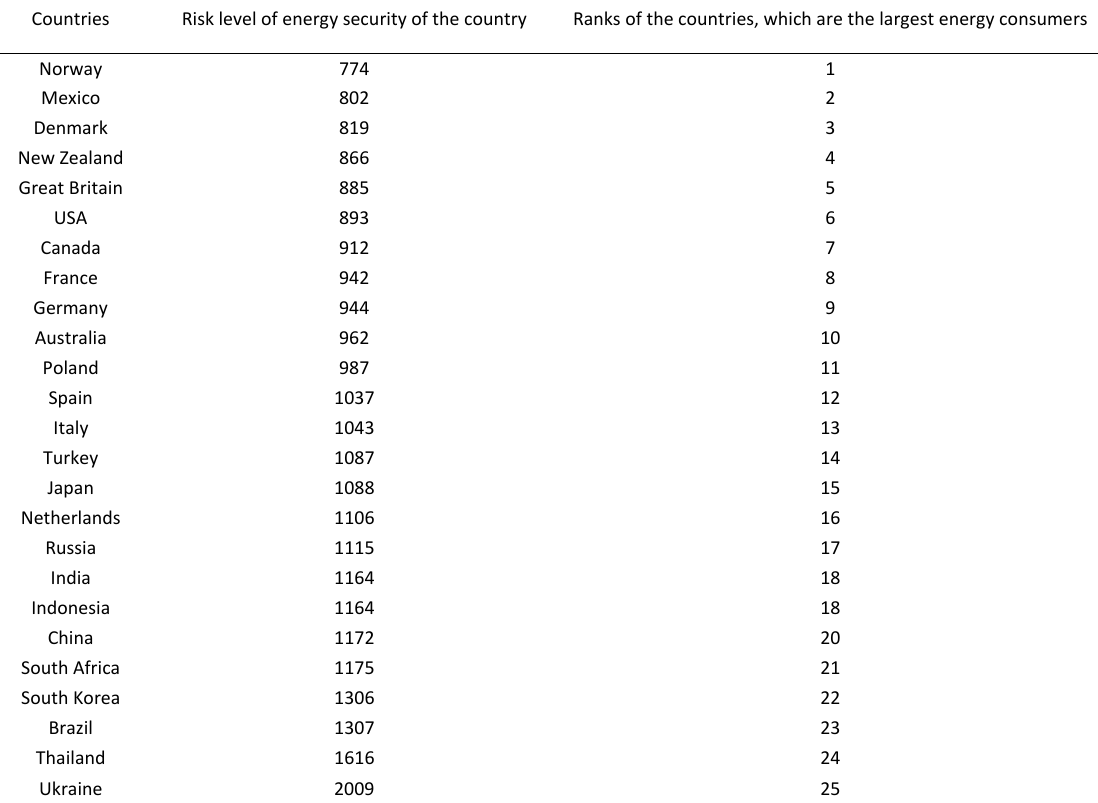
Table 2: Ranking of energy security levels in the world countries with high energy use (IIESR, 2018) Countries Risk level of energy security of the country Ranks of the countries, which are the largest energy consumers Norway 774 1 802 2 819 3 866 4 885